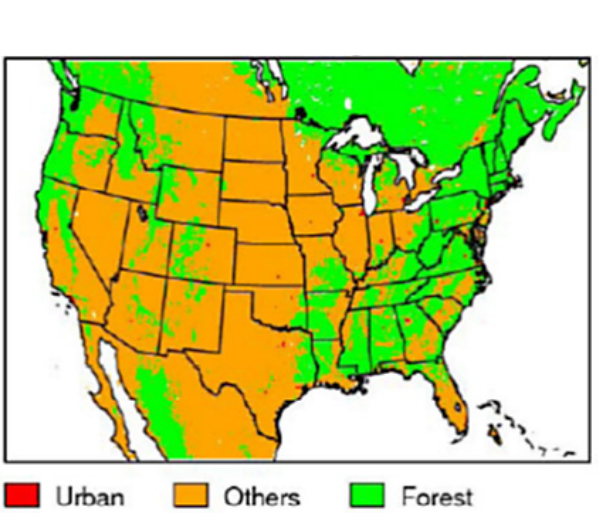
Fig. 1. Three AVHRR USGS LULC geographical regions (red: ur- ban regions, including USGS LULC type 1; green: forest regions, including USGS LULC types 11–15; and orange: other regions, in- cluding all the rest except the urban region, the forest region, and water bodies (Anderson et al., 1976; Loverland et al.,